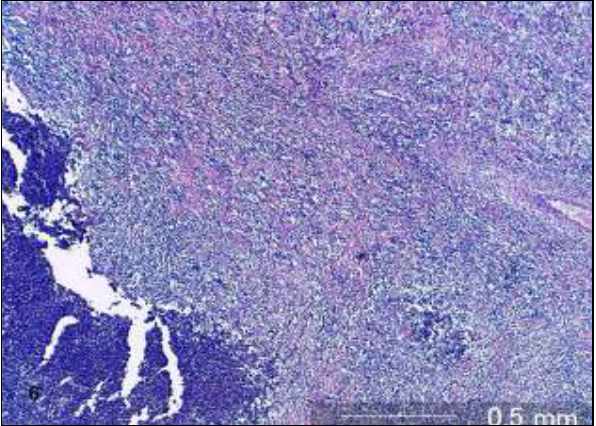
single abscess as circumscribed hyperechoic mass while liver appears as hypoechoic structure.